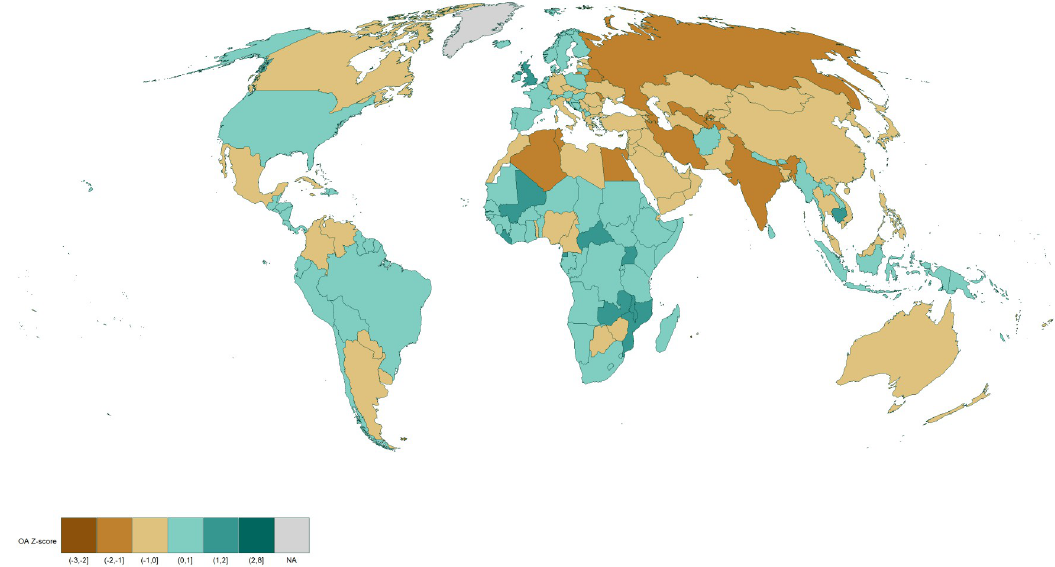
Fig 1. Weighted z-score and normalized map of the number of OA publications by country. Red indicates that a country is above the world average, blue indicates it is below the world average. White represents the world average. Contains information from OpenStreetMap and OpenStreetMap Foundation, which is made available under the Open Database License.